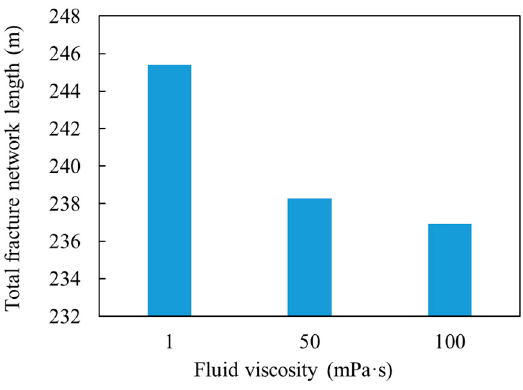
Figure 15. Fracture network lengths achieved with different injection fluid viscosities.